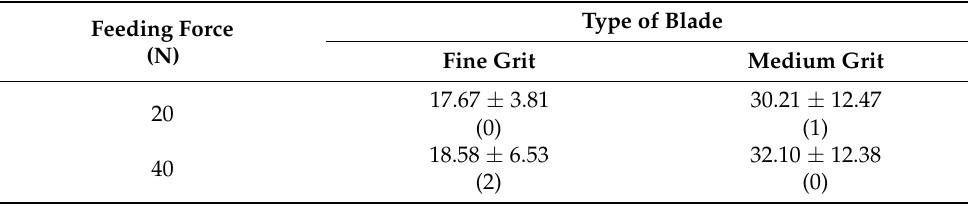
Table 2. Means and standard deviations (mean ± S.D.) of microtensile bond strength (MPa) of each group. The number of premature debonding specimens is presented in parentheses ( n = 10/group). Feeding Force